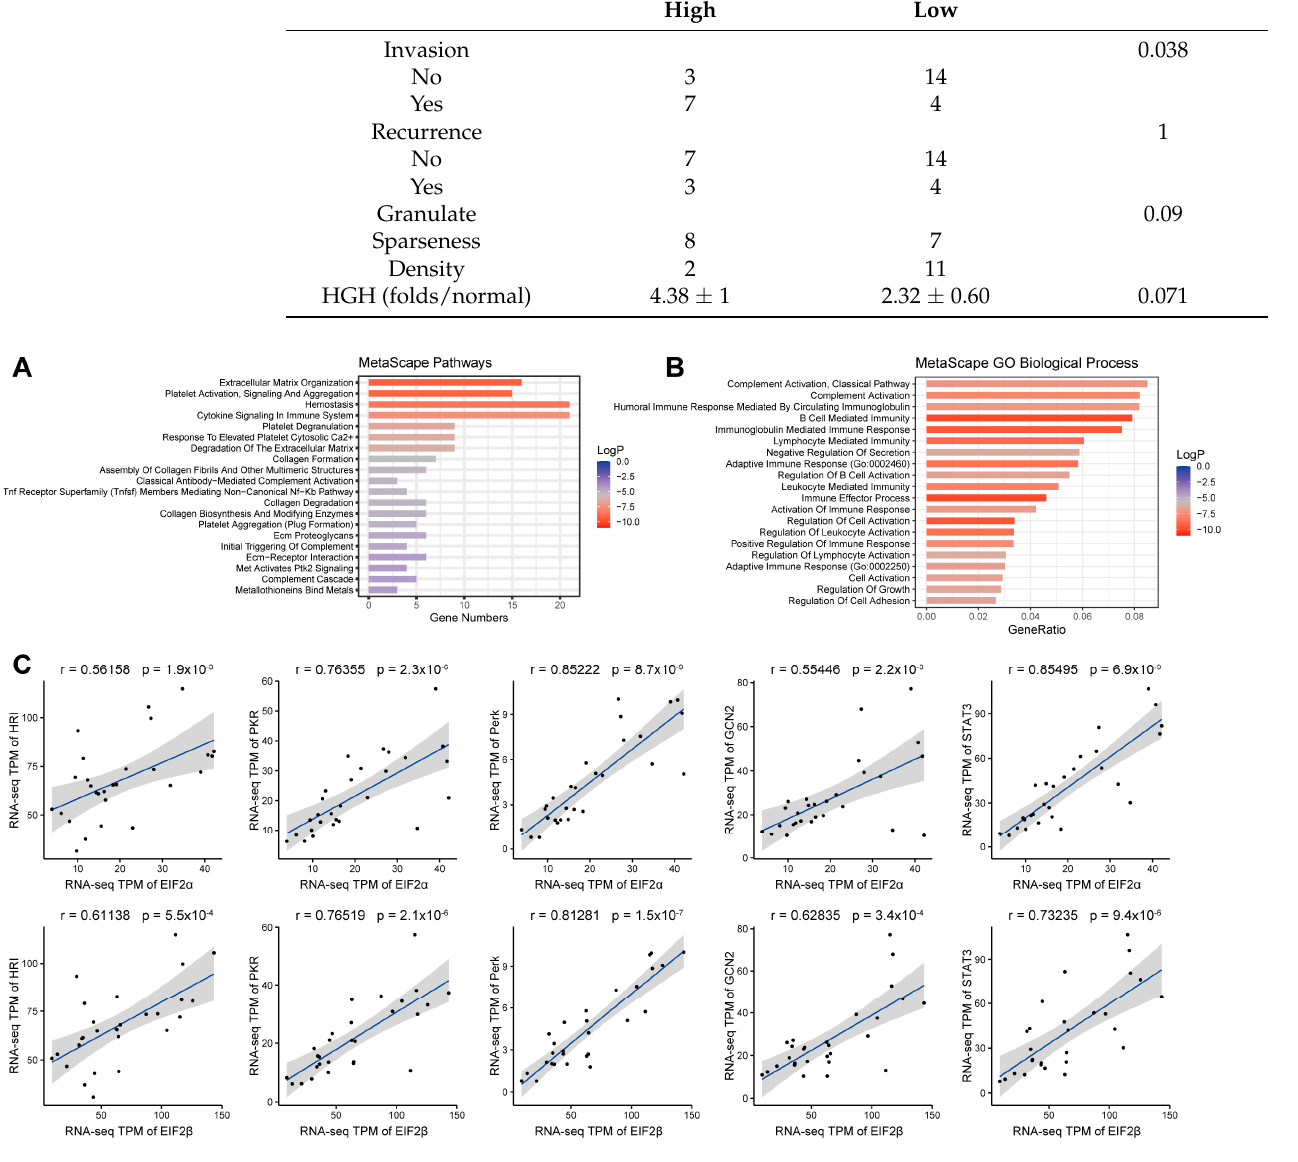
Figure 3. Differential gene-enrichment analyses of different EIF2 β groups in 28 patients with somatotroph adenomas. ( A , B ): Metascape enrichment analysis, including pathways and GO terms. ( C ): Correlation analysis of EIF2 α / β and EIF2AK1-4 and STAT3.